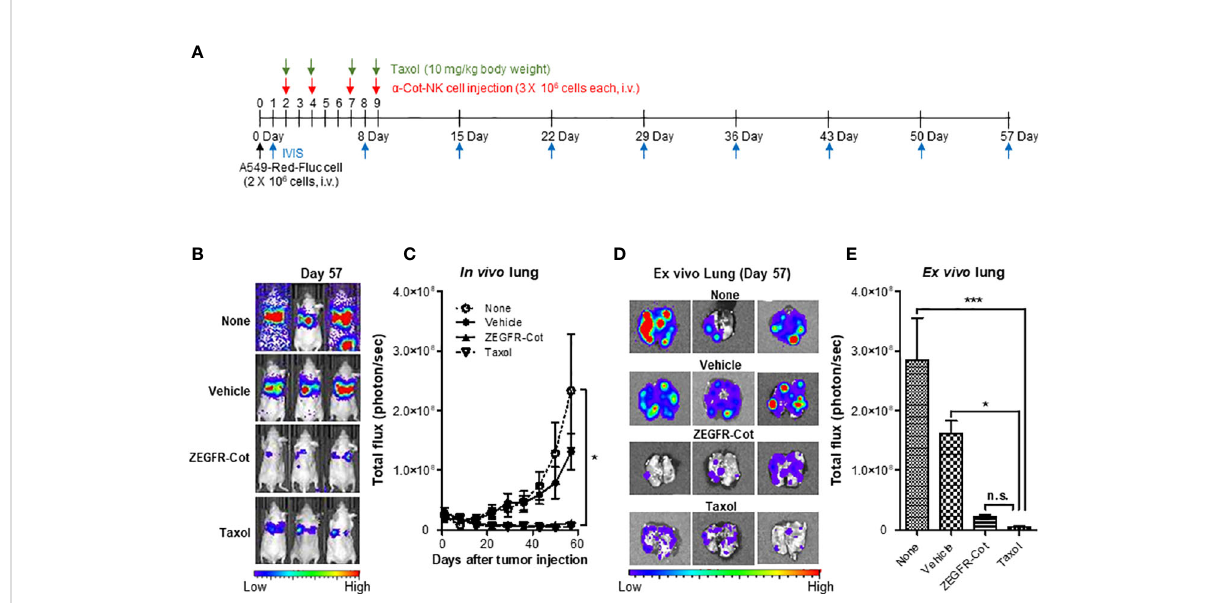
FIGURE 5 a -Cot-NK92 cells with a conjugator inhibit tumor growth in an in vivo lung cancer model. (A) The schedule of in vivo studies using luciferase- expressing A549-Red-Fluc cells in mouse metastasis model treated with a -Cot-NK92 cells with or without ZEGFR-Cot. (B) Representative in vivo bioluminescence imaging of each group treated with a -Cot-NK92 cells with or without ZEGFR-Cot and Taxol (10 mg/kg body weight) compared to levels in the untreated group (none) on day 57 after tumor cell injection. (C) The tumor burden of each group (n = 10) in in vivo lungs quanti fi ed as total fl ux (photon/s), which was monitored weekly for 57 d after the A549-Red-Fluc injection. (D, E) Representative BLI (D) and total quantitative fl ux (E) in ex vivo lungs of each group extracted on day 57 after in vivo BLI. *** P < 0.001 vs. none; * P < 0.05 vs. vehicle; Tukey ’ s multiple comparison test; n.s.: not signi fi cant. Bioluminescent images were acquired after an i.p. injection of D-luciferin (150 mg/kg body weight) and analyzed using the Living Image Software. Total fl ux data were plotted as mean ± SD. Cot, cotinine; NK, natural